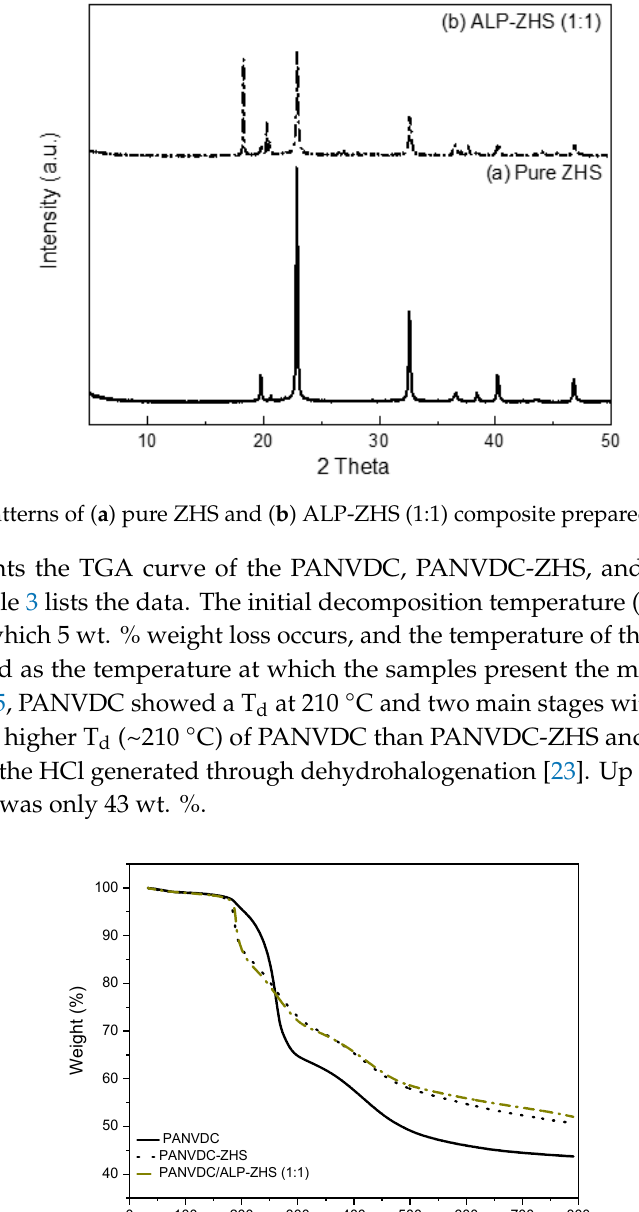
Figure 5. TGA curves of PANVDC, PANVDC-ZHS, and PANVDC/ALP-ZHS (1:1) films.